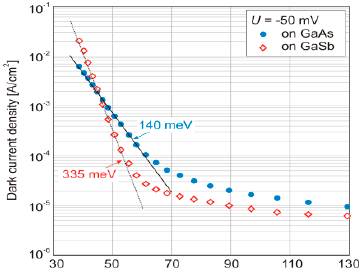
Figure 3. Arrhenius plots of the dark current density at -50 mV for T2SLs based ICIPs grown on GaSb and GaAs